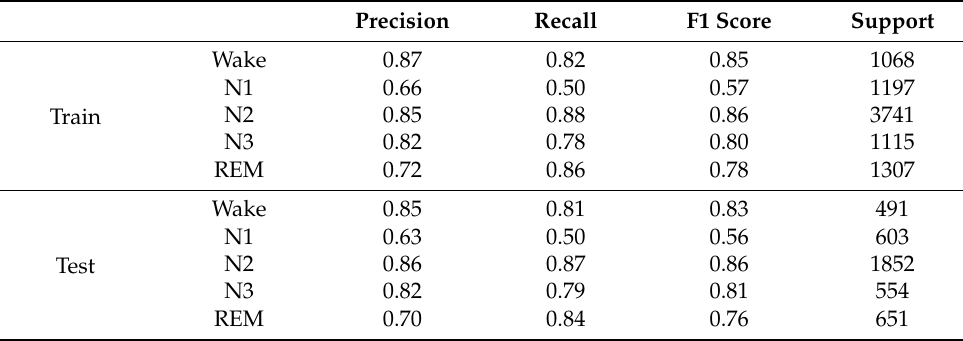
Table 3. Classification result of each class in the Reference